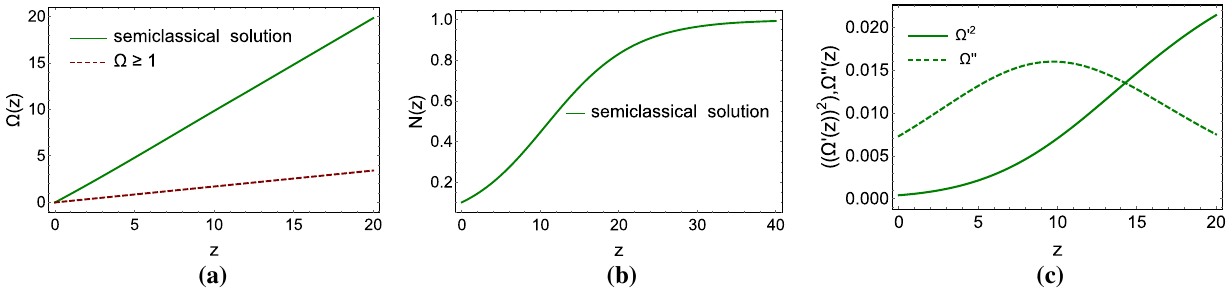
Fig. 6 a Function (cid:20)( z ) versus z : the solid line shows the solution of Eq. (77) with the initial value of (cid:20) 0 = 0 . 1. The dotted line describes the solution at N → 1 which is (cid:20) = 1 8